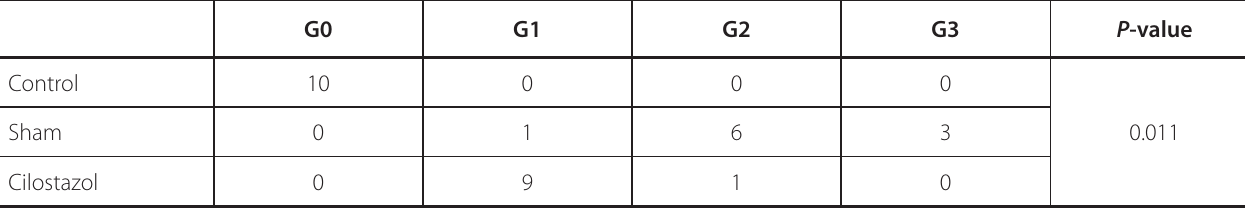
Table 3 . Comparison of pathology results between the groups.